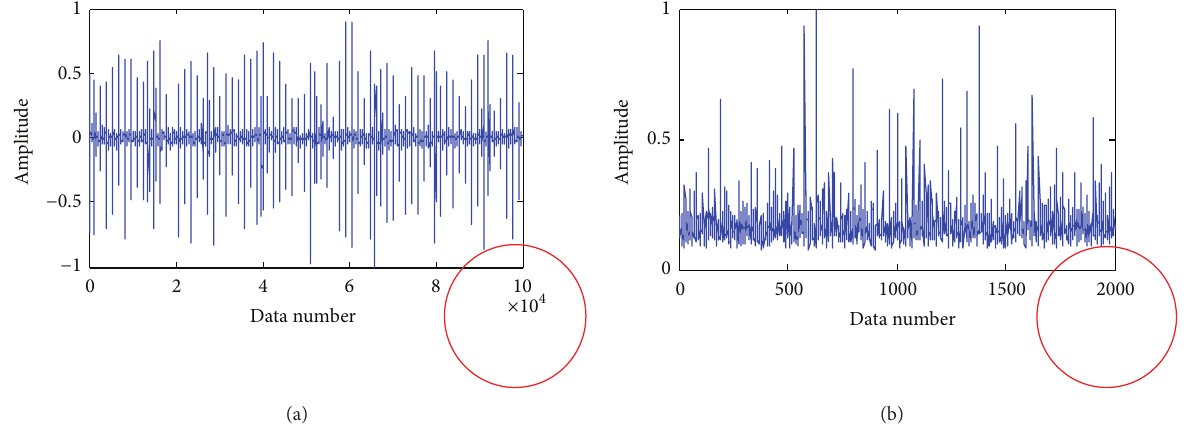
Figure 8: (a) Original signals and (b) symptom parameter wave using kurtosis.